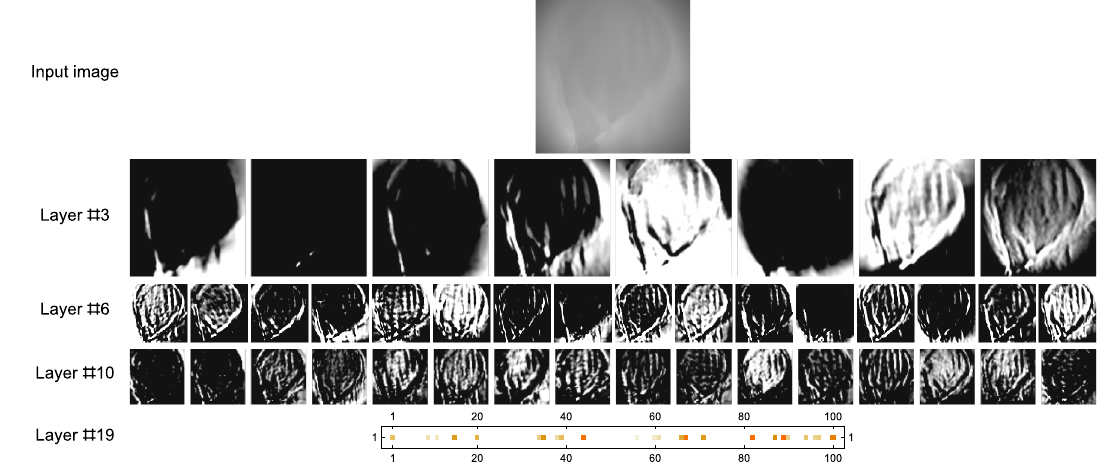
Figure 7. An example of a 72-year-old individual (predicted age = 71.6) evaluation. Even though we can see almost no details in the input image, the model can identify vertical (in this orientation) structures, which seems to be key for age identification.